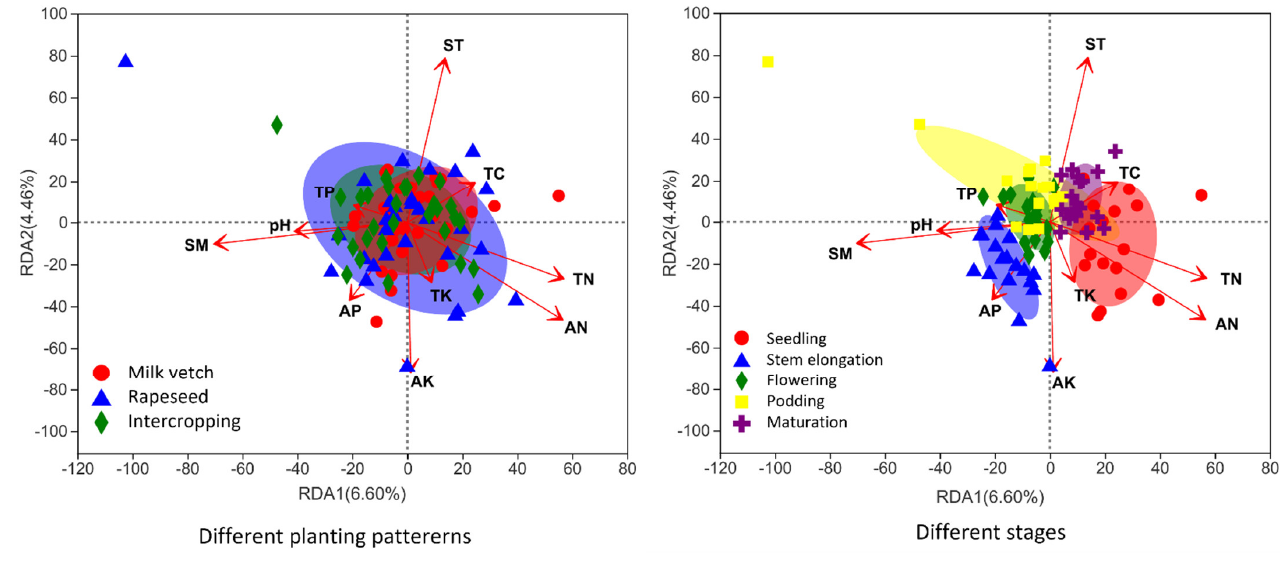
Figure 7. Redundancy analysis (RDA) of soil microorganisms and environmental factors. Points with different colors or shapes in the figure represent different sample groups. The red arrow represents the environmental factor, and the length of the arrows represent the influence degree (Interpretation amount) of the environmental factor on microorganisms; The angle between the arrows represents positive and negative correlations (acute angle: positive correlation; obtuse angle: negative correlation; right angle: no correlation). SM represents soil moisture; ST represents soil temperature; pH represents soil pH value; TP represents total phosphorus; TN represents total nitrogen; TC represents total carbon; AN represents alkali-hydrolyzed nitrogen; TK represents total potassium; AP represents available phosphorus; AK represents available potassium.